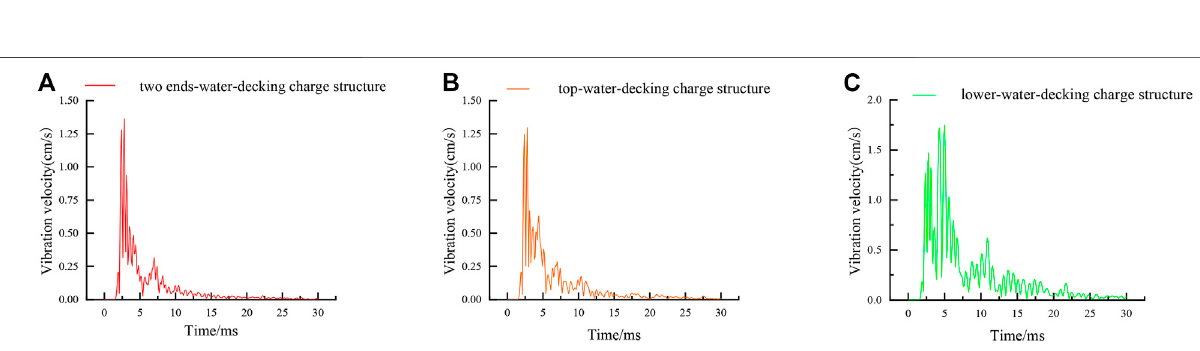
the buffer effect of the water column at the bottom of the model increases the time of shock wave action, the acceleration of vibration, and the velocity of vibration.